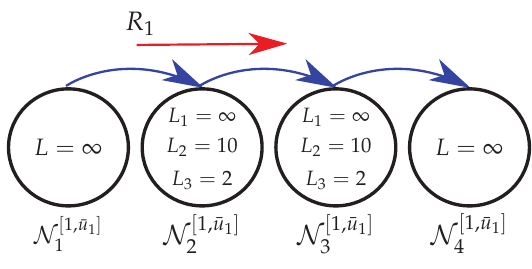
Figure 2. Illustrative network for the computation of P ( ξ )